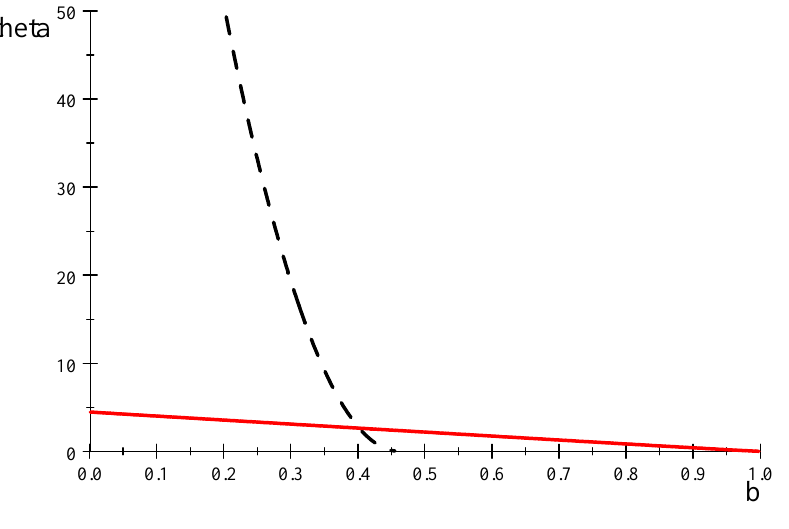
Figure 6: Changes of labour market tightness with respect to leisure value: US